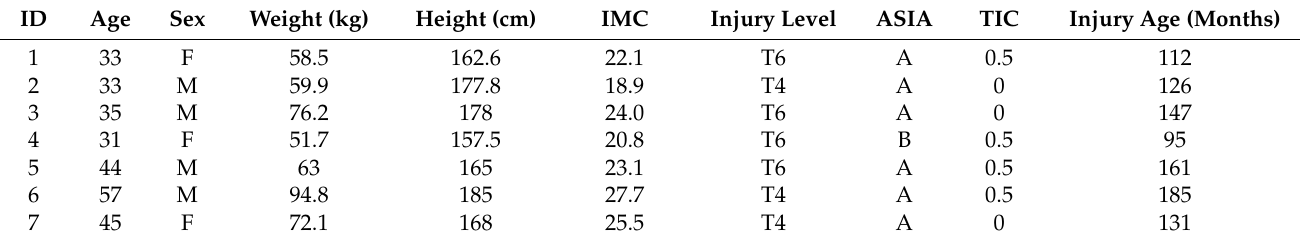
Table 1. Physical characteristics of